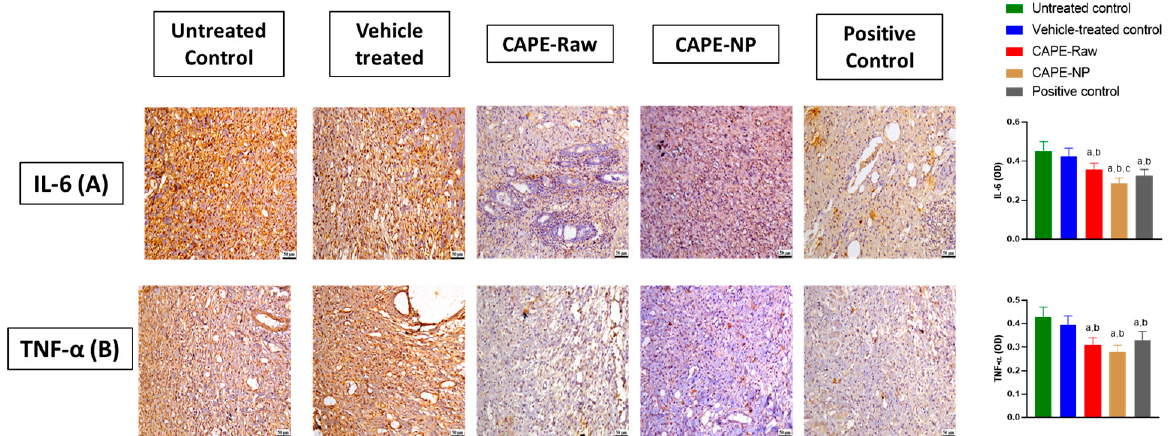
Figure 6. Effects of CAPE-NPs on the expression of ( A ) IL-6 and ( B ) TNF- α . Data are expressed as mean (n = 6) ± SD. (a) Significantly different from untreated control at p < 0.05, (b) significantly different from vehicle-treated control at p < 0.05, and (c) significantly different from CAPE-raw at p < 0 .05.